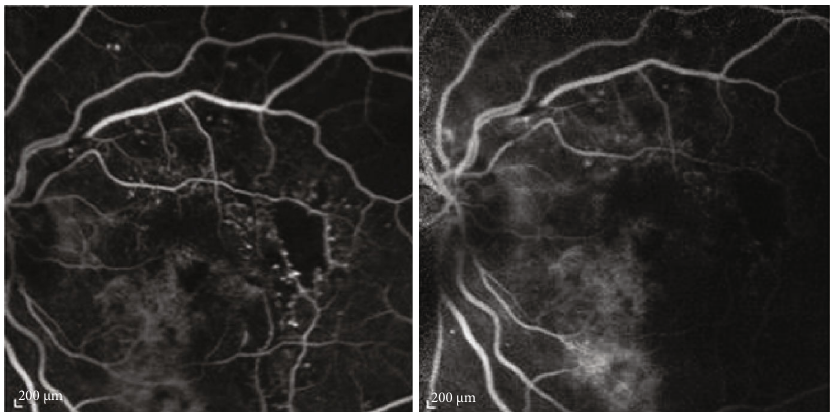
Figure 2: Fluorescein angiography of a male patient with diabetic macular edema, showing macular ischemia, which was associated with higher monocytes and higher